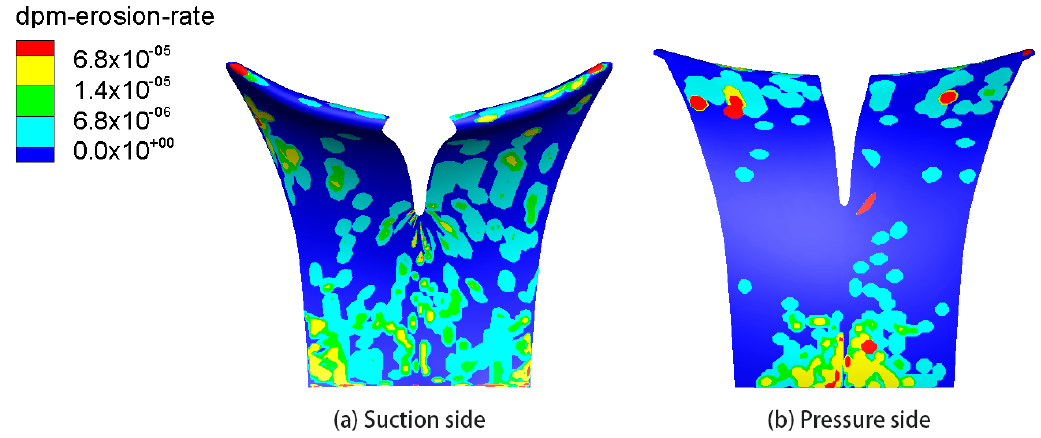
Figure 8. Silt erosion on blade surface (units: µ m/s, particle size: 0.04 mm).